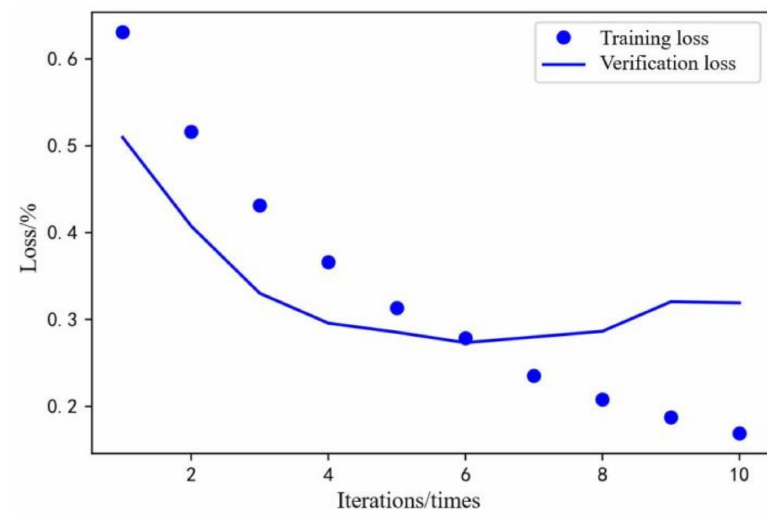
Figure 8. Training loss and verification loss.